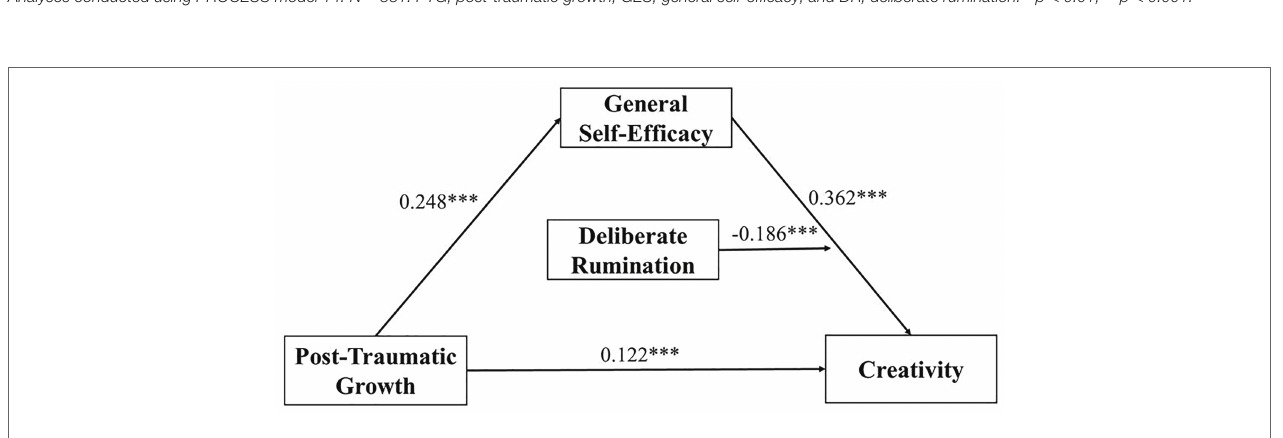
FIGURE 1 | The moderated mediation